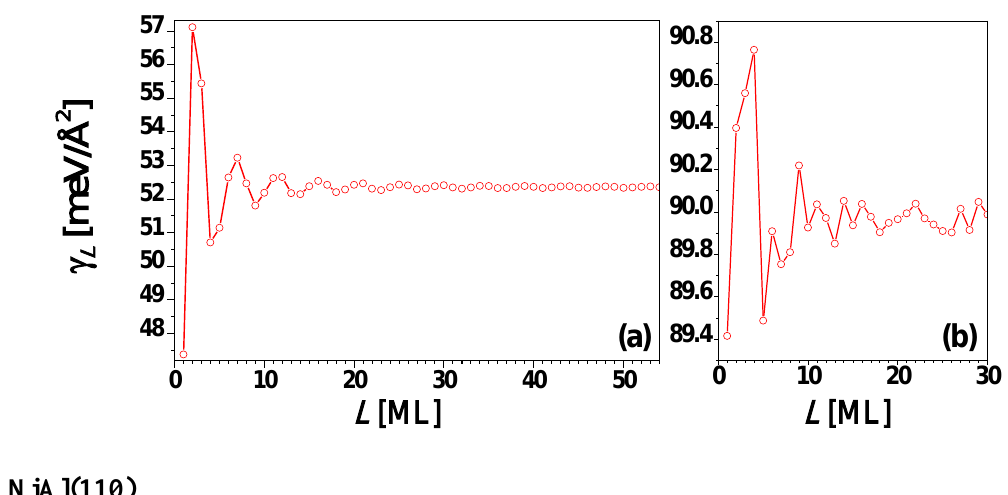
versus thickness L for a freestanding Cu(100) nanofilm Figure 11. Surface free energy γ L from (a) EGM and (b) DFT calculations,